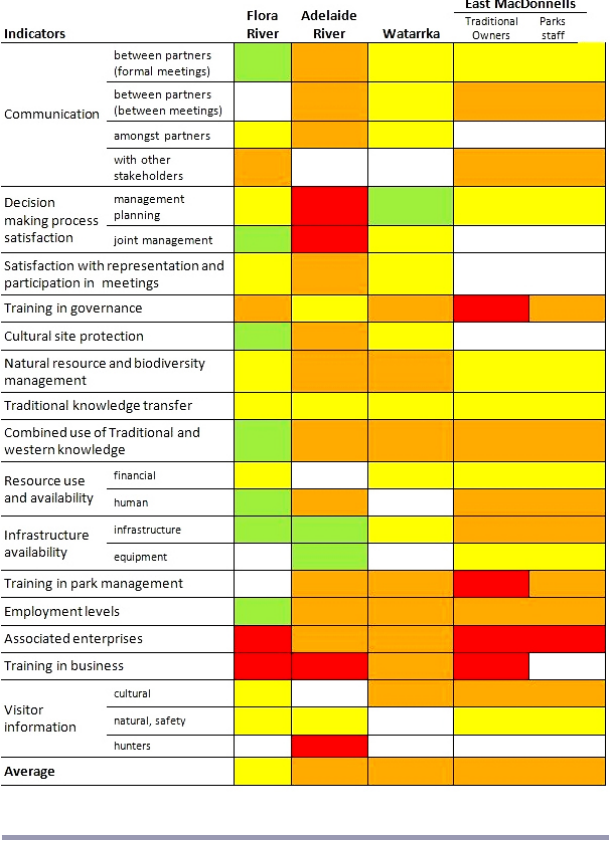
Table 3 . Average indicator scores across four parks in the Northern Territory, Australia, categorized by sustainable livelihood capital category and elements of the protected area management cycle.